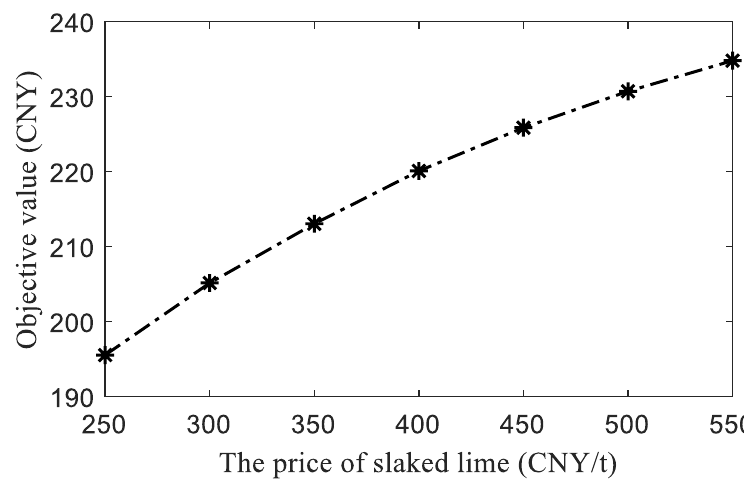
Figure 8. The relationship between slaked lime price and total cost.